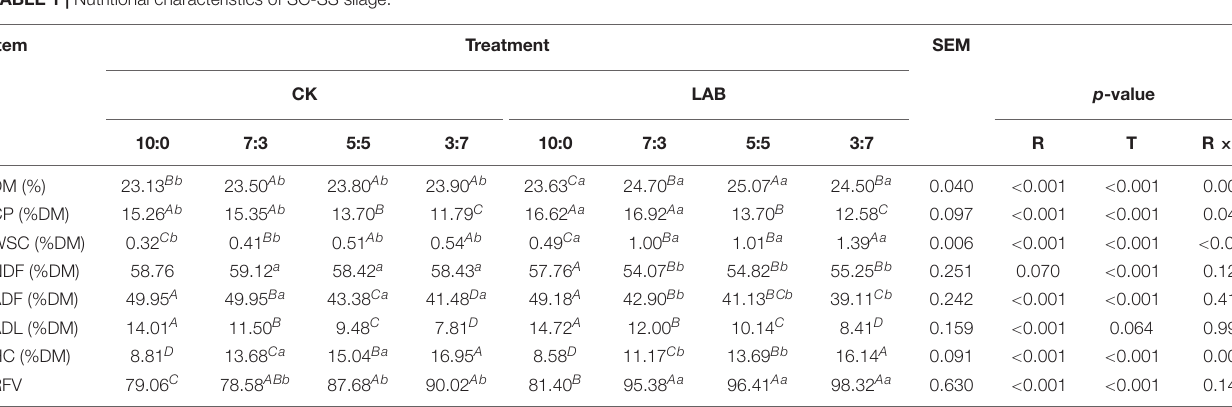
FIGURE 1 | Fermentation characteristics of SC-SS silage. (A) pH value. (B) The content of lactic acid. (C) The content of acetic acid. (D) The ratio of lactic acid to acetic acid. (E) The content of butyric acid. (F) The content of ammonium-N. * p < 0.05; ** p < 0.01; *** p < 0.001; **** p < 0.0001. TABLE 1 | Nutritional characteristics of SC-SS